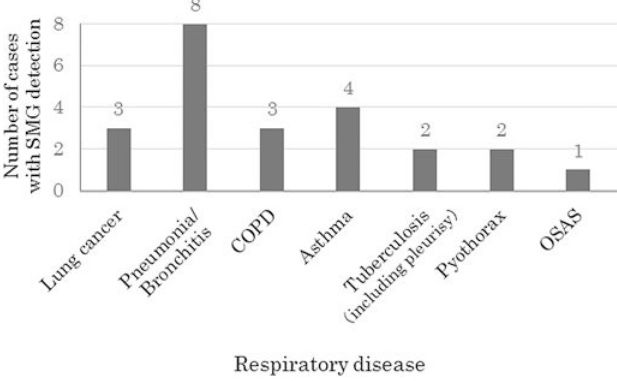
Figure 4 Number of cases with SMG detection according to respiratory